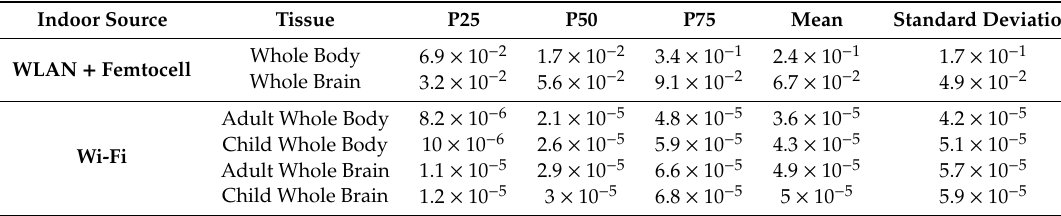
Table 1. Descriptive statistics of the cumulative distribution functions of indoor exposure profiles (specific absorption rate (SAR) in mW/kg).